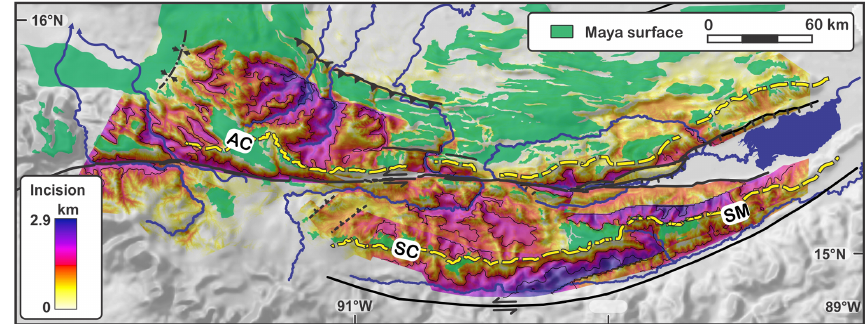
Figure 3. Incision below the middle Miocene Maya surface, based on the elevation of surface remnants (upland relict surface). Incision contour line spacing is 1km. Dashed yellow lines show range drainage divides. AC stands for Altos de Cuchumatanes, SC stands for Sierra de Chuacús, SM stands for Sierra de las Minas, and VA stands for volcanic